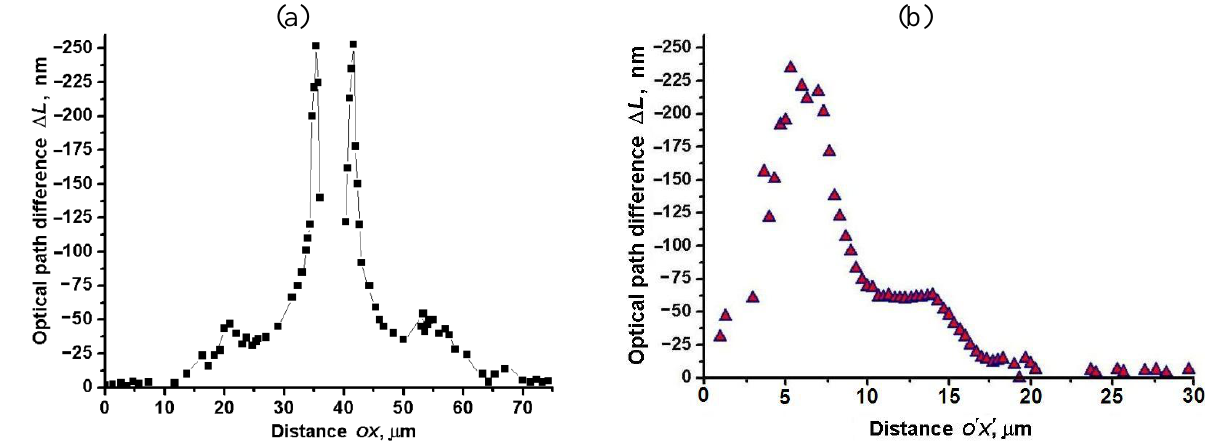
𝒅 vs. distance OX calculated using 𝒆𝒇𝒇 , f = 100 rms